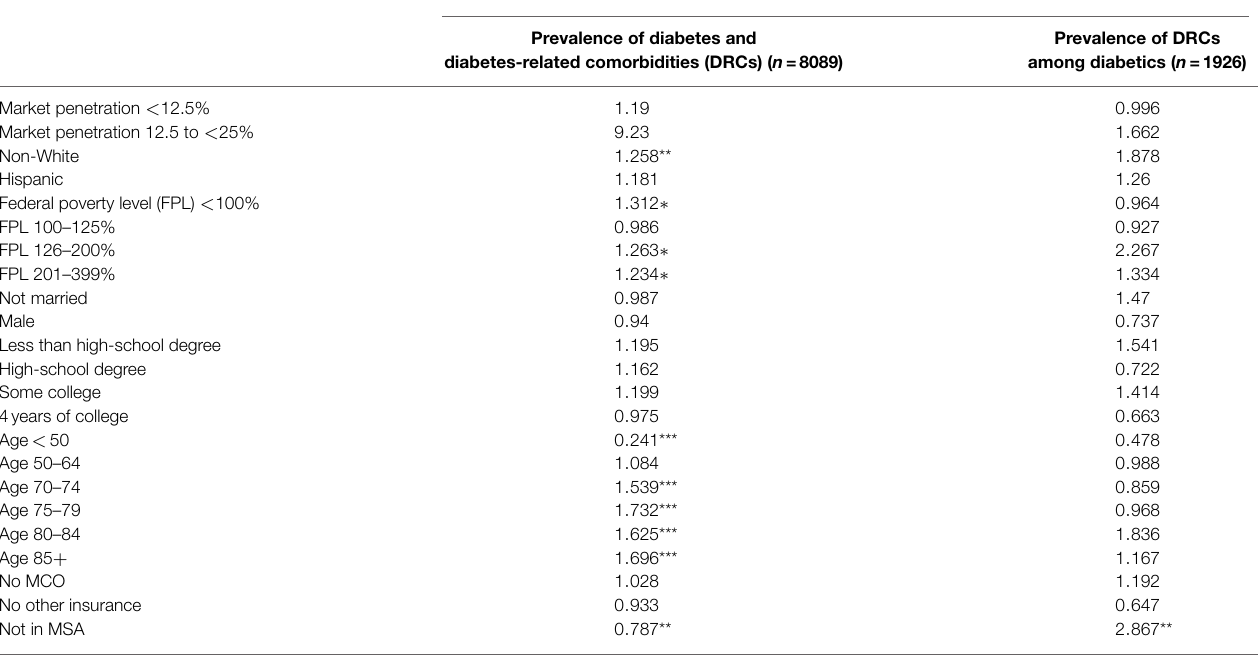
Variables Odds ratios